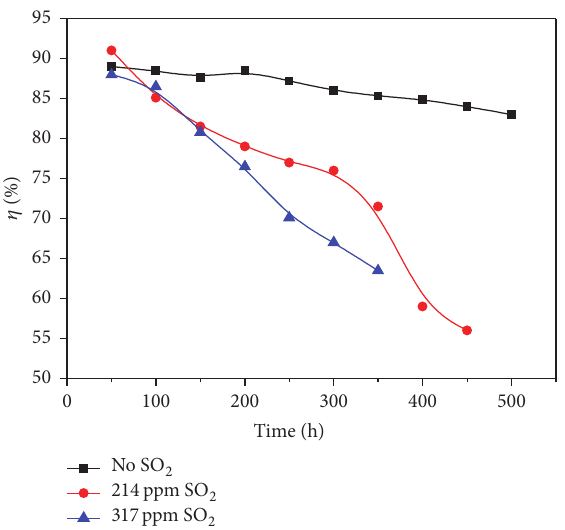
Figure 6: The influence of circulating time on the CO 2 removal efficiency [17] ( 𝑈 𝑔 = 86 Nm 3 /h, U